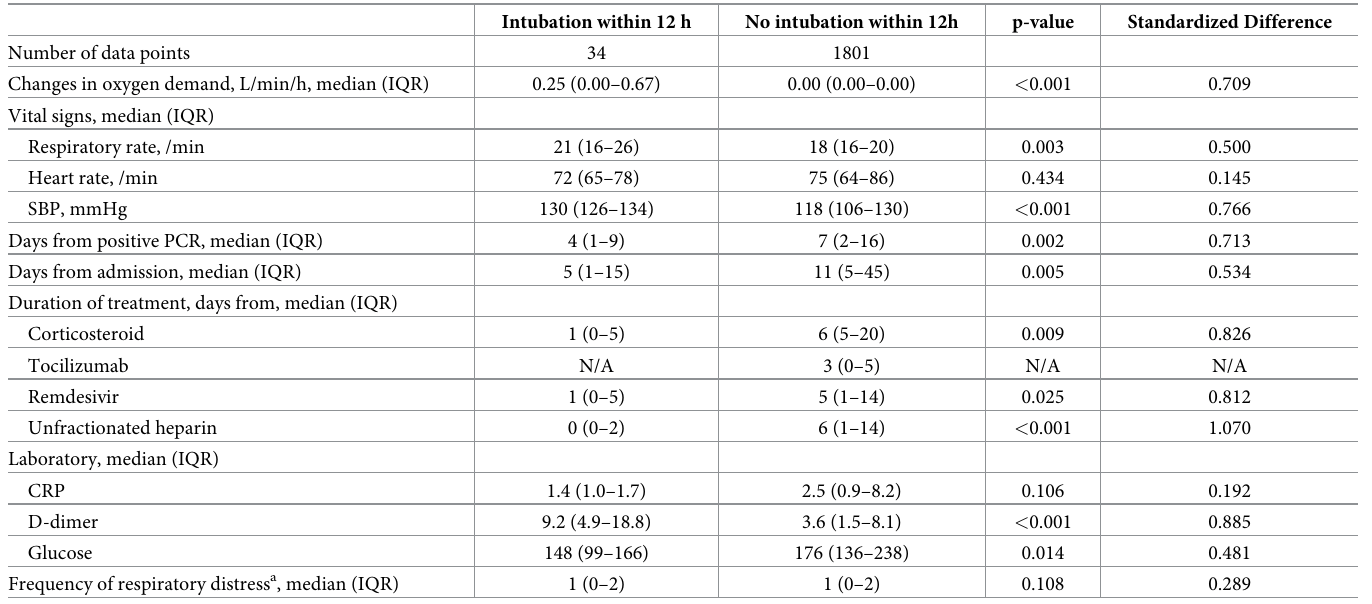
Table 2. Clinical information associated with changes in oxygen